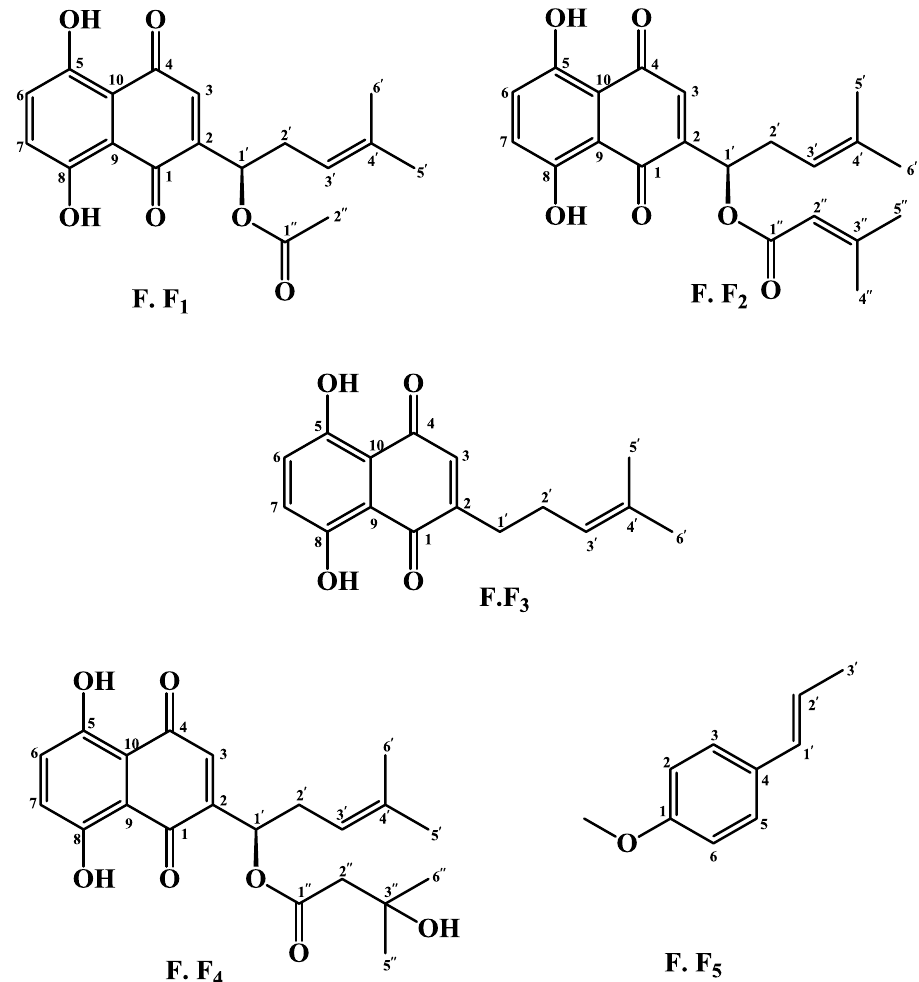
Figure 7. Chemical structure of purified compounds from the cyclohexane extract of O. dichroanthum .